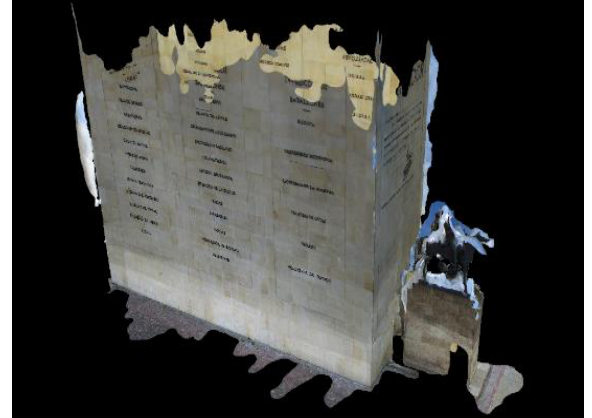
Figure 9: 3D Mesh of the Monument with the data capture processing generated by the CANON camera from the point of view of the earth's surface . Source: Own